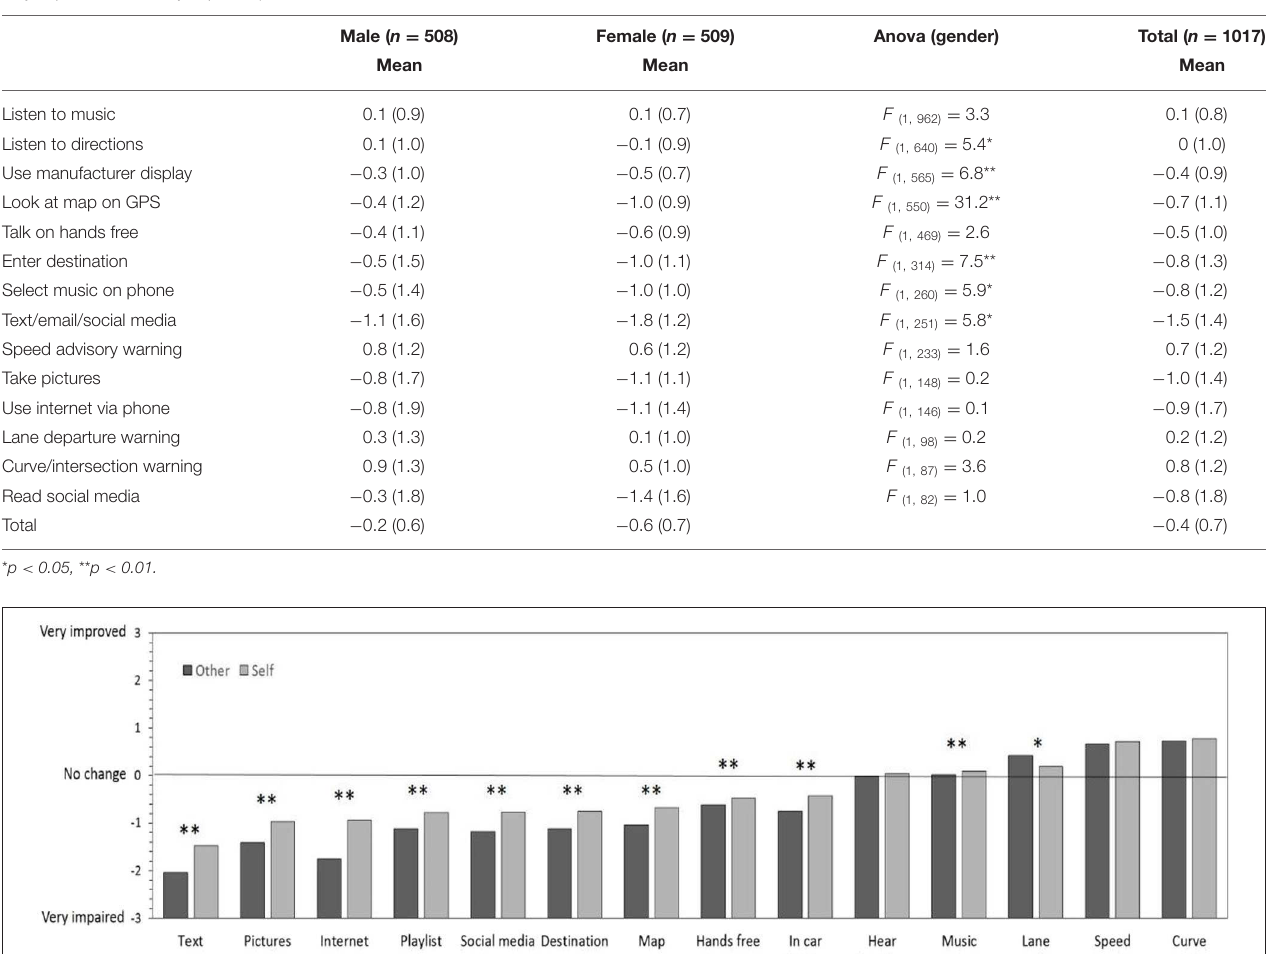
TABLE 10 | The mean and standard deviation of the driving safety ratings by gender for the respondents engaging in each IVIS behavior or event (ratings were from − 3 very impaired to + 3 very